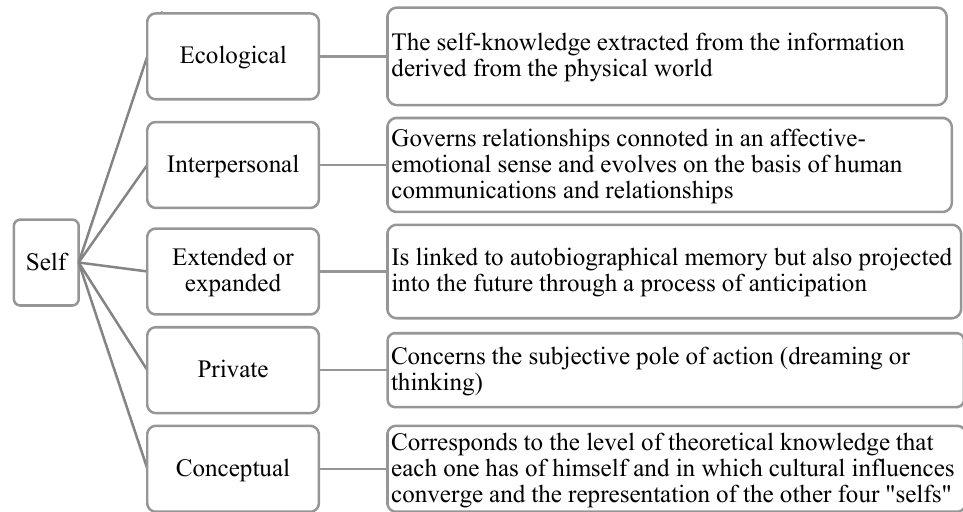
Figure 2. Structure of the self, according to Ulric Neisser (personal elaboration).